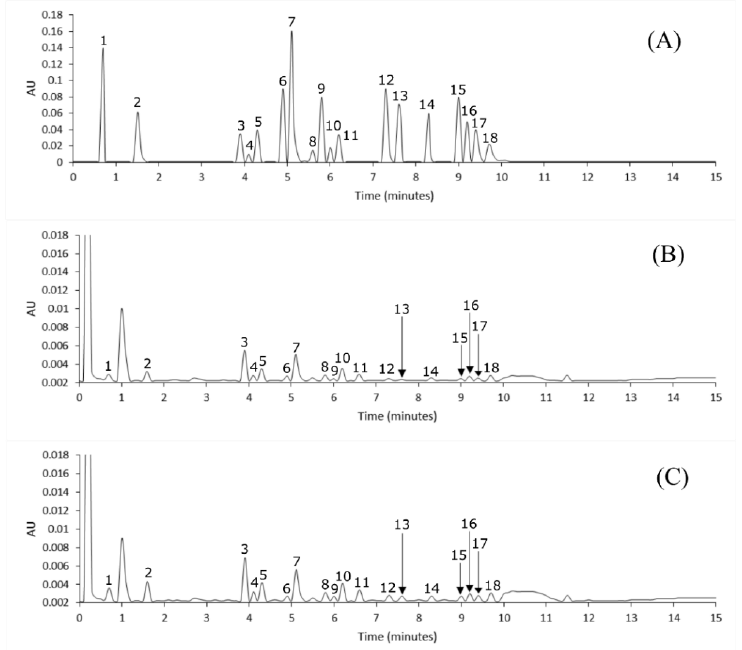
Figure 1. Chromatogram of: ( A ) Polyphenols standards at a concentration of 75 µg mL −1 analyzed at 280 nm. ( B ) Sample of immature Habanero pepper harvested at 160 post-transplant days